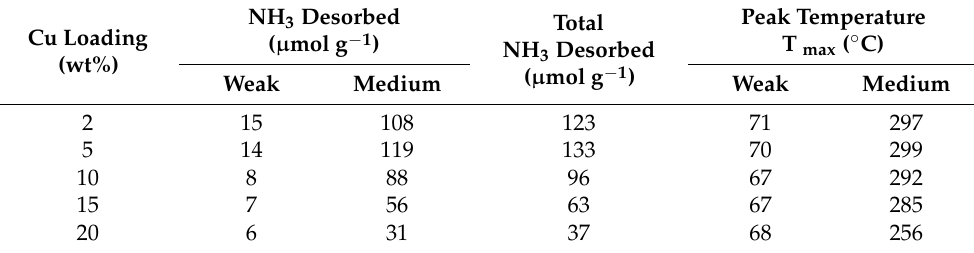
Table 5. Hydrogenation of GVL to 2-MTHF over various Cu/SiO 2 catalysts with various Cu load- ings.